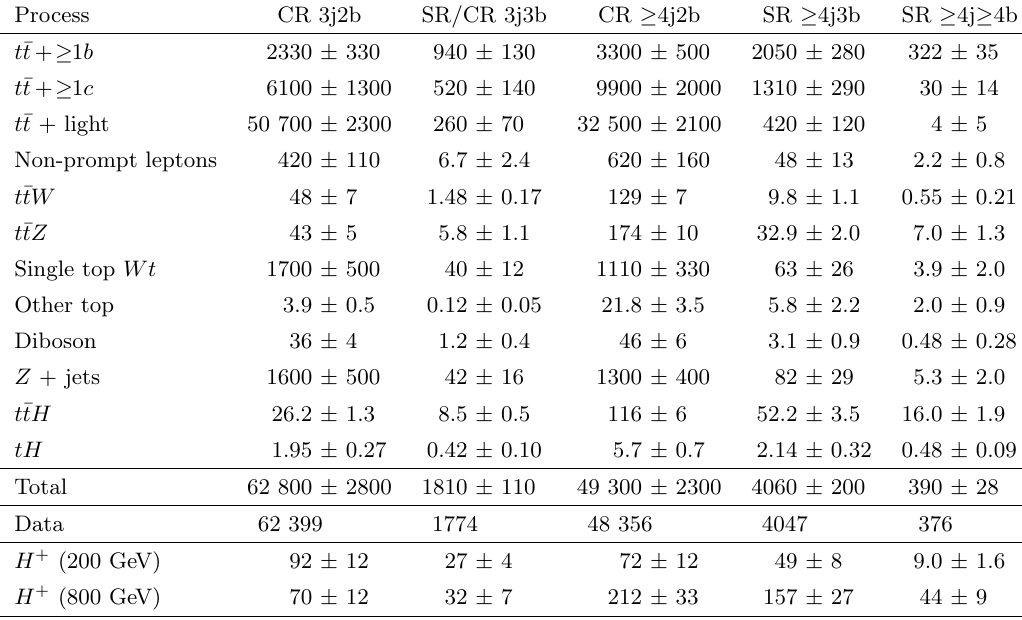
Table 4. Event yields of the SM background processes and data in all categories of the ‘‘ (cid:12)nal state, after the (cid:12)t to the data under the background-plus-signal hypothesis ( m expected event yields for the H + signal masses of 200 GeV and 800 GeV are shown with pre-(cid:12)t uncertainties and assuming a cross-section times branching ratio of 1 pb. The quoted uncertainties include both the statistical and systematic components. The uncertainties take into account corre- lations and constraints of the nuisance parameters. ‘Other top’ includes contributions from Zt as well as s - and t -channel single top production.